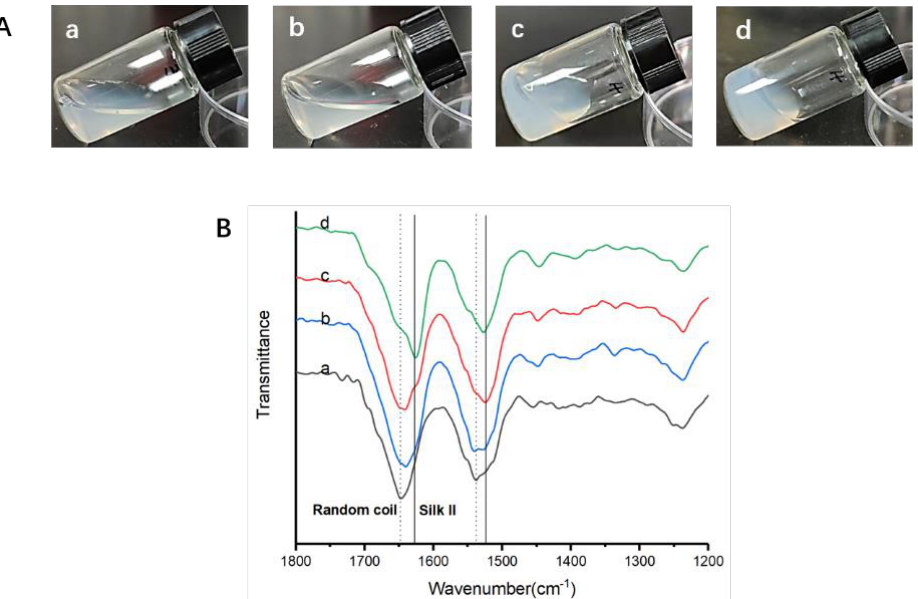
Figure 3. The morphology ( A ) and FTIR results ( B ) from solution to hydrogel. a. Fresh silk fibroin (SF); b. Mixed with crystal silk nanofiber solution; c. Flowable hydrogel; d. hydrogel. Deconvolution of the infrared spectral region in the amide I region was performed by Peakfit to assess the contents of different secondary structures (Table 1). The content of β -sheet, the most ordered crystalline structure, increased from 21.9 ± 0.5 to 48.4 ± 0.3 percent. The a-helix and turns/bends are intermediate states before silk II (mainly β -sheet) formation. The content of amorphous random coil structures and intermediate state struc- ture decreased, while the crystalline β -sheet content of silk fibroin increased significantly during the gelation process. Table 1. The relative ratio of secondary structures in solutions or hydrogels. Assignment